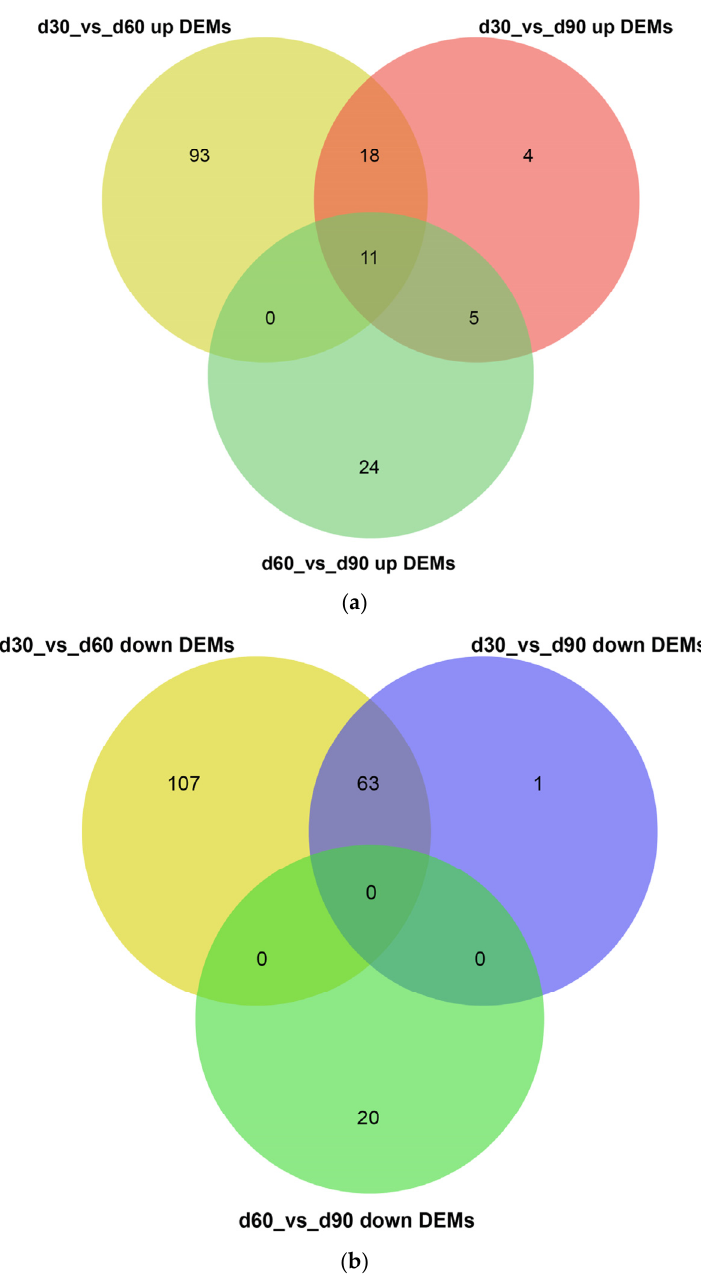
Figure 3. Venn diagram of differentially expressed miRNAs. In the Venn diagram, the number of overlapping triangular regions represents the number of common DEMs among the corresponding comparison combinations (d30 vs. d60, d90 vs. d60, and d30 vs. d90), and the non-overlapping region represents the unique differential genes in each comparison combination. ( a ) The up-regulated DEMs in three comparison groups; ( b ) The down-regulated DEMs in three comparison groups.